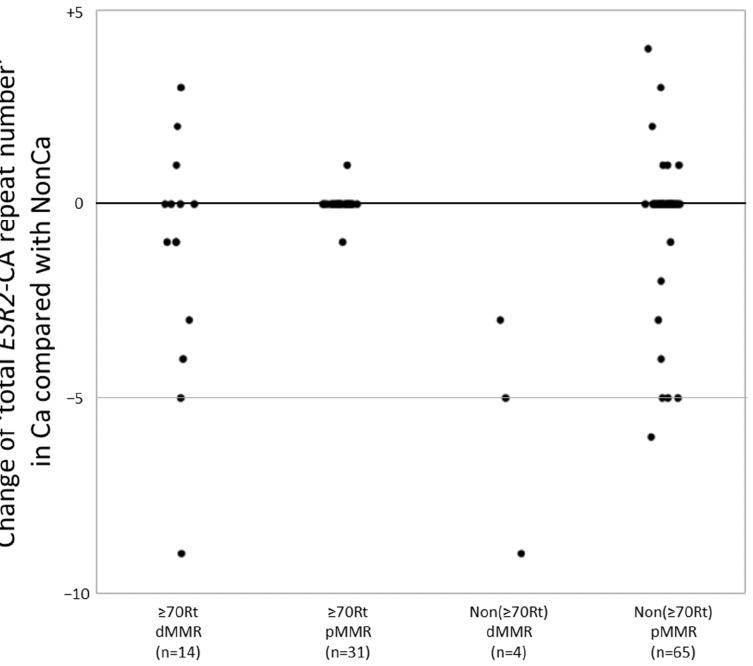
Figure 2. The ‘total ESR2 -CA repeat number’ in cancerous tissue (Ca) was compared with that in non-cancerous tissue (NonCa) in each patient. The distribution of the difference of ‘total ESR2 -CA repeat number’ between Ca and NonCa was compared among four groups categorized by the age/locus and mismatch repair protein (MMR) status. dMMR, deficient-MMR; pMMR, proficient- MMR; ≥ 70Rt, right-sided case ≥ 70 y/o; Non( ≥ 70Rt), other than ≥ 70Rt.